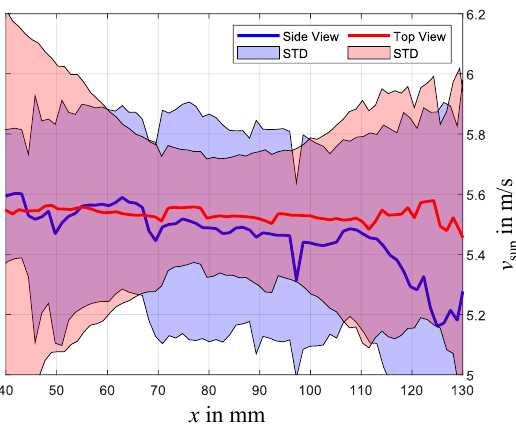
Figure 7. Mean flow velocity for the top view (red) and the side view (blue) displayed with their standard deviation (STD) for a volume flow of